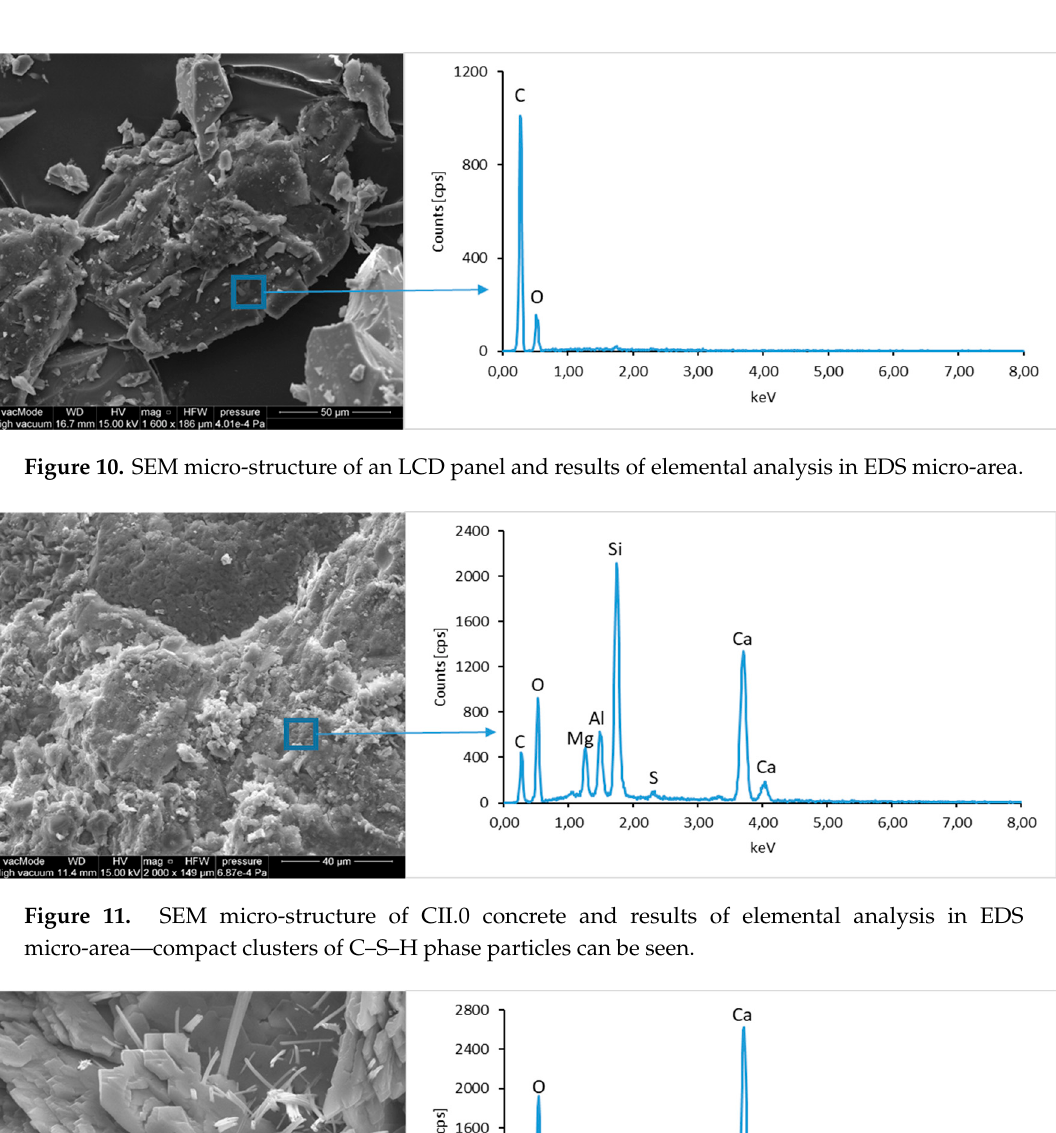
Figure 13. SEM micro-structure of CII.0 concrete and results of elemental analysis in EDS micro- area—well-developed portlandite and C–S–H phase crystals are shown. Figure 14. SEM micro-structure of CII.1 concrete and results of elemental analysis in EDS micro-area for spherical forms of fly ash, angular LCD forms and needle-like forms of C–S–H phase are visible.